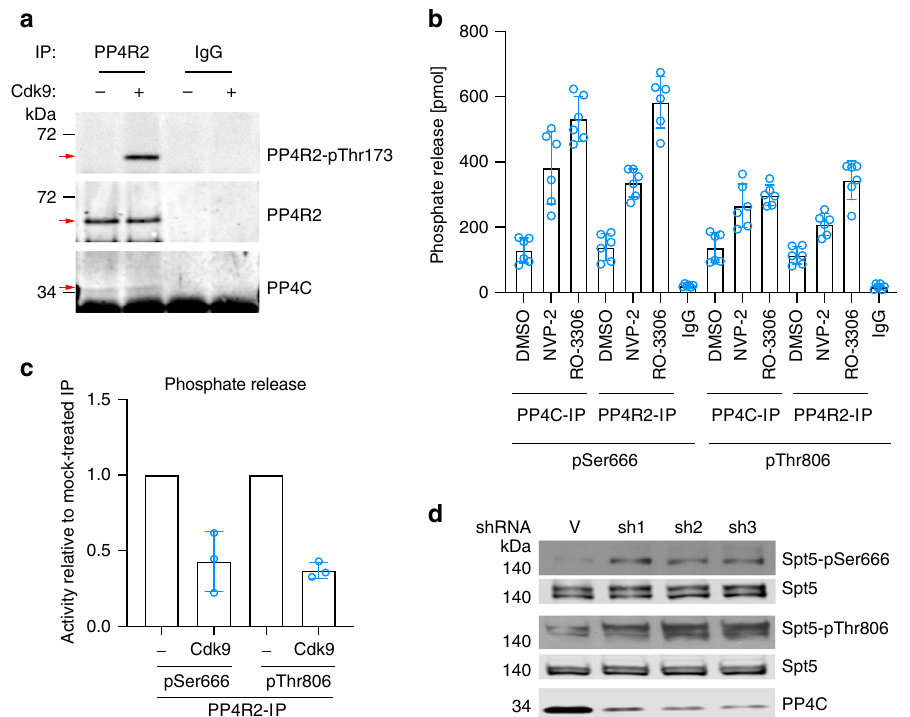
Fig. 6 PP4 is active toward pSer666 and pThr806 and negatively regulated by Cdk9. a PP4R2 was immunoprecipitated from HCT116 cell extracts, incubated in vitro with puri fi ed, recombinant Cdk9/cyclin T1 and ATP, and immunoblotted with antibodies to PP4R2-pThr173, total PP4R2, or PP4C, as indicated at right. b HCT116 cells were mock treated (DMSO) or treated with inhibitors of Cdk9 (NVP-2) or Cdk1 (RO-3306), as indicated, for 1 h before lysis and extract preparation. Anti-PP4R2, anti-PP4C, or control IgG immunoprecipitates, as indicated, were incubated with Spt5-derived phosphopeptides containing pSer666 or pThr806, as indicated, and phosphate release was measured colorimetrically. Error bars indicate ±s.d. of six biological replicates ( n = 6). c Anti-PP4R2 immunoprecipitates were incubated with 5 ng puri fi ed, recombinant Cdk9/cyclin T1 and ATP or mock treated (as indicated), washed and tested for phosphatase activity toward an Spt5-derived phosphopeptide containing pSer666 or pThr806, as in b . Activity of Cdk9-treated samples is plotted as a fraction of activity of the corresponding, mock-treated immunoprecipitate (de fi ned as 1.0). Error bars indicate ±s.d. from three biological replicates ( n = 3). Individual data points from biological replicates are shown in the plots ( b and c ). d HCT116 cells were infected with lentivirus expressing shRNA targeting PP4C (three different hairpins, sh1-3) or a nontargeted control vector (V), and chromatin fractions were immunoblotted for Spt5- pSer666, Spt5-pThr806, total Spt5 (to ensure equal loading),and total PP4C (to assess ef fi ciency of depletion). Source data are provided as a Source data fi